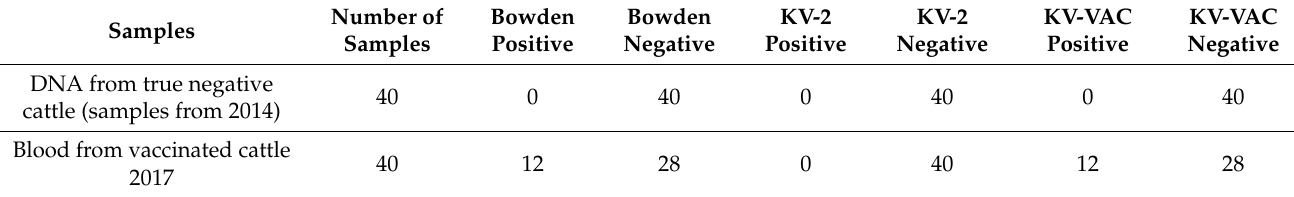
Table 7. Additional testing on vaccinated animals and negative